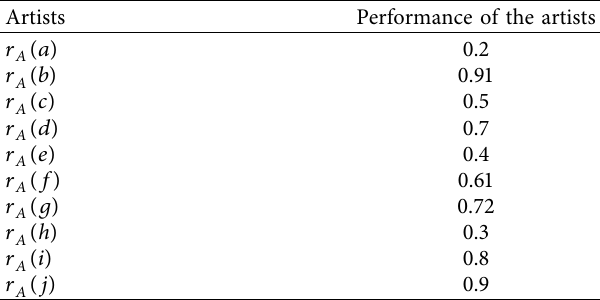
Table 1: Performance of all artists after initial screening.